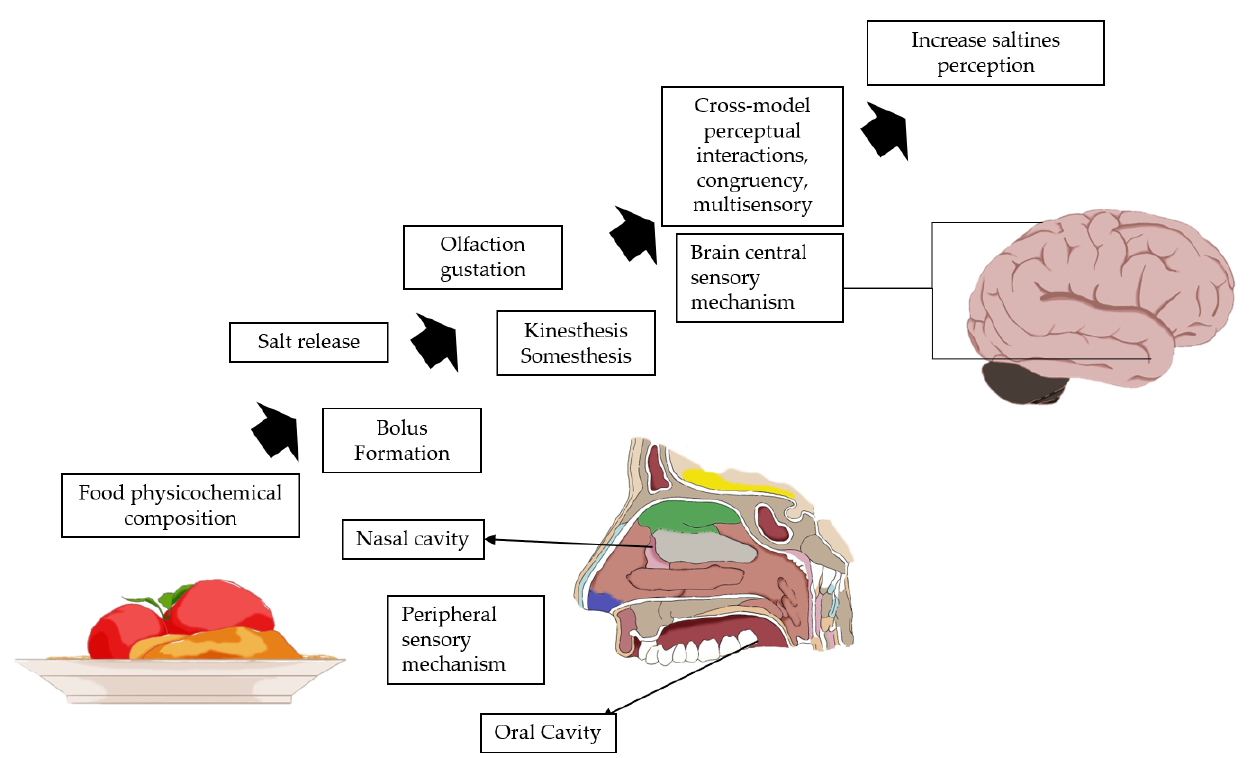
Figure 4. Experience crossmodal sequential processes to improve salty perception. Adapted from Ref. [4] with permission from the Royal Society of Chemistry.